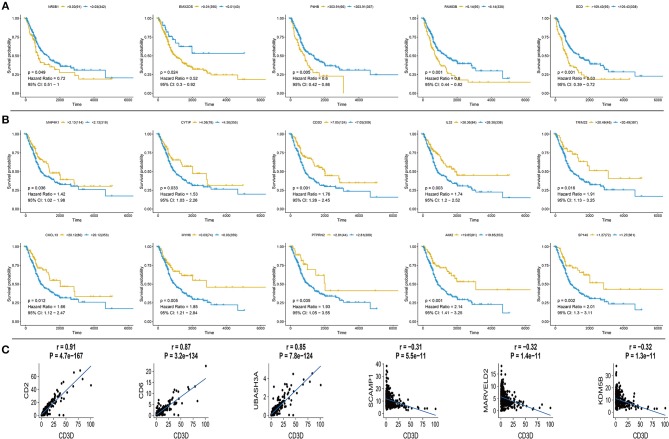
Survival curve for hub genes of 433 TCGA bladder cancer samples and analysis of Pearson's correlation of CD3D (A) Five up-regulated hub genes with poor prognosis in bladder cancer, p-value, Hazard ration, and 95% CI are shown. (B) Ten down-regulated hub genes with poor prognosis in bladder cancer, p value, Hazard ration and 95% CI are shown. (C) Pearson's correlation of CD3D with top 3 positive and negative genes in bladder cancer from TCGA database, relevant gene expression versus change upon CD3D, p-value and correlation are shown.